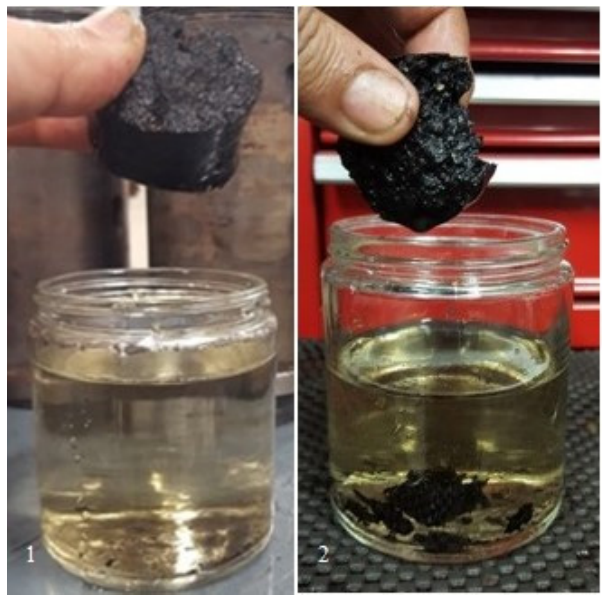
Figure 13. After 24 h of water immersion: ( 1 ) 10.75% moisture, ( 2 ) 16% moisture.